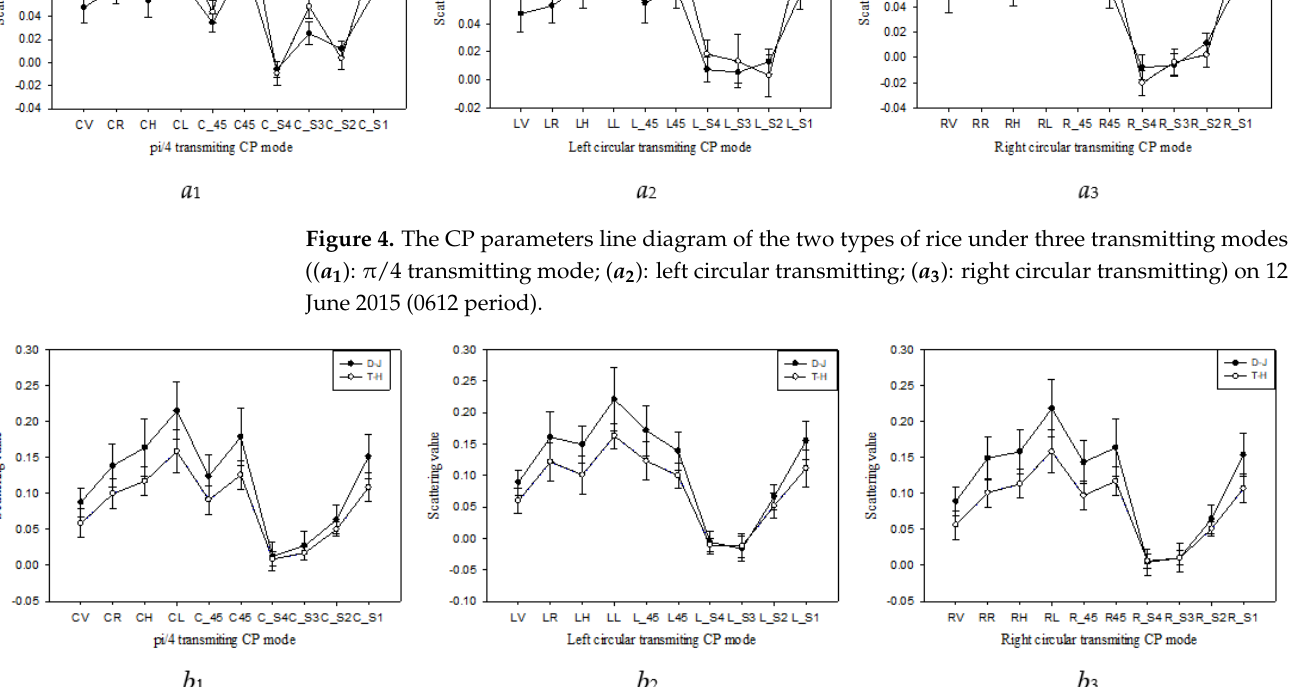
Figure 6. The CP parameters line diagram of the two types of rice under three transmitting modes (( c 1 ): π /4 transmitting mode; ( c 2 ): left circular transmitting; ( c 3 ): right circular transmitting) on 23 August 2015 (0823 period).